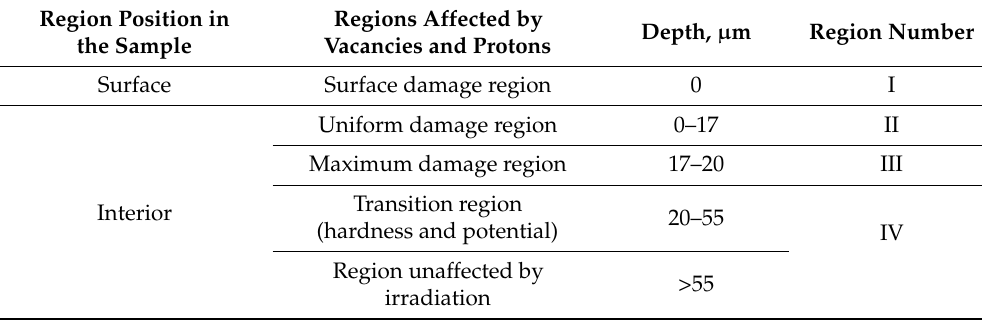
Figure 1. SRIM 2008 simulation of the damage zone and implanted protons distribution: region I at the surface; region II, uniform damage; region III, maximum damage; and IV, unirradiated region along the sample depth. Table 1. Regions affected by vacancies and implanted protons.